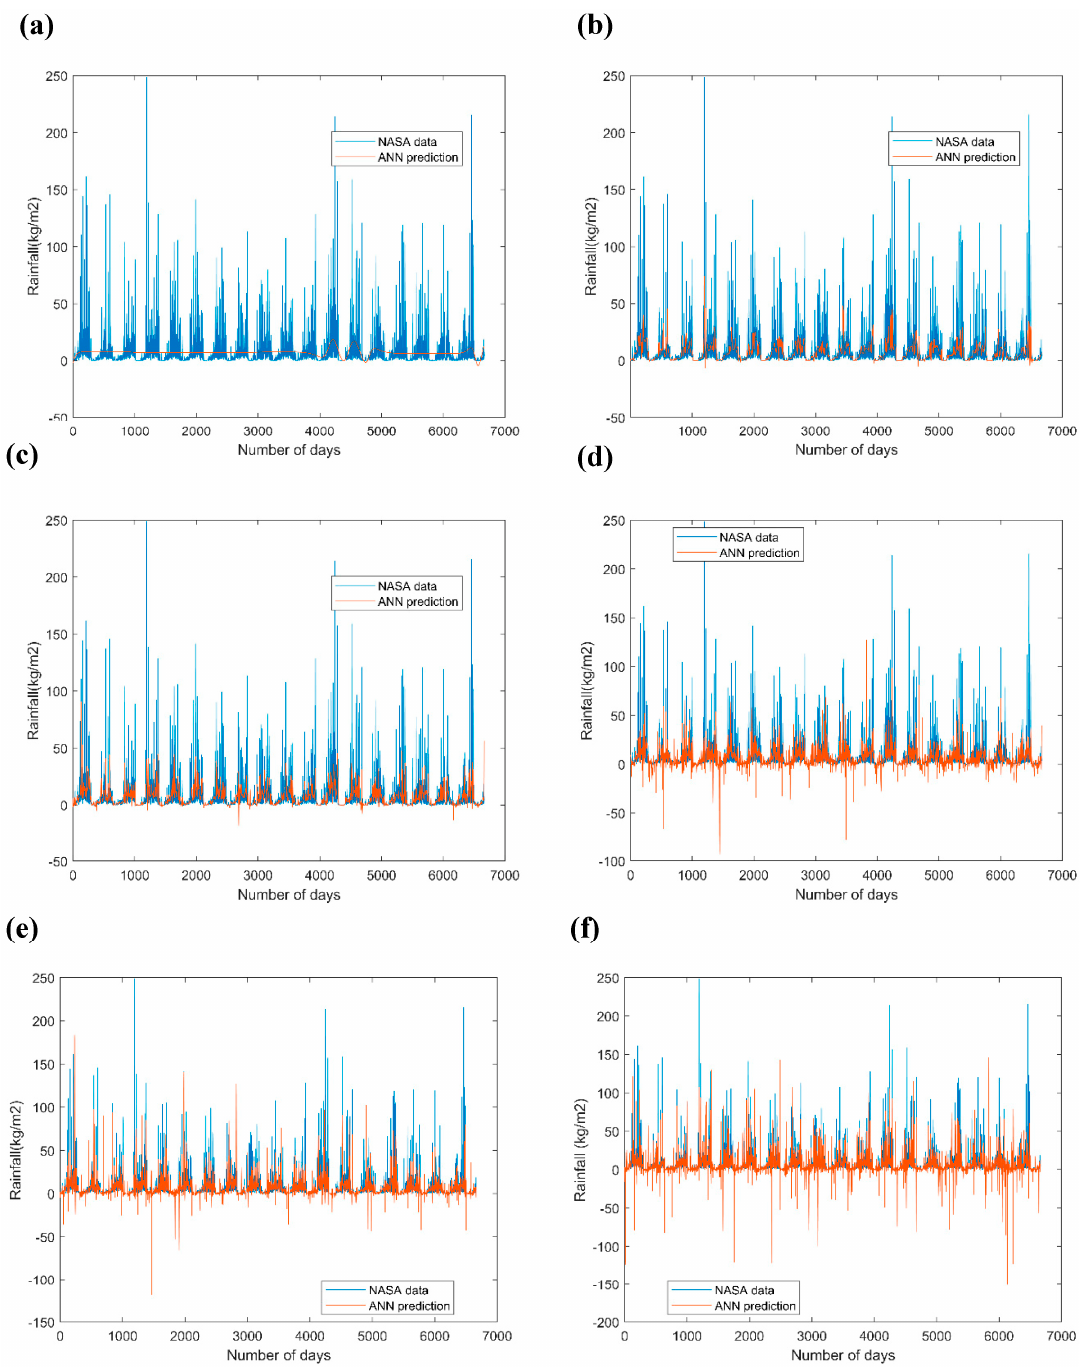
Figure 8. Rainfall plot of the NASA data vs. the ANN model with ( a ) 10 hidden units, ( b ) 500 hidden units, ( c ) 1000 hidden units, ( d ) 1500 hidden units, ( e ) 2000 hidden units, and ( f ) 2500 hidden units.